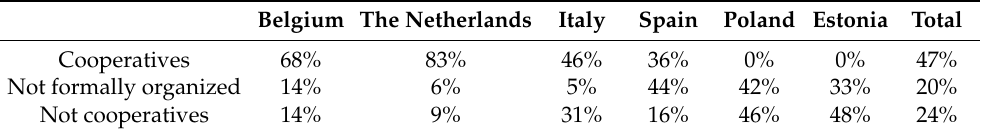
Table 5. CAIs’ legal